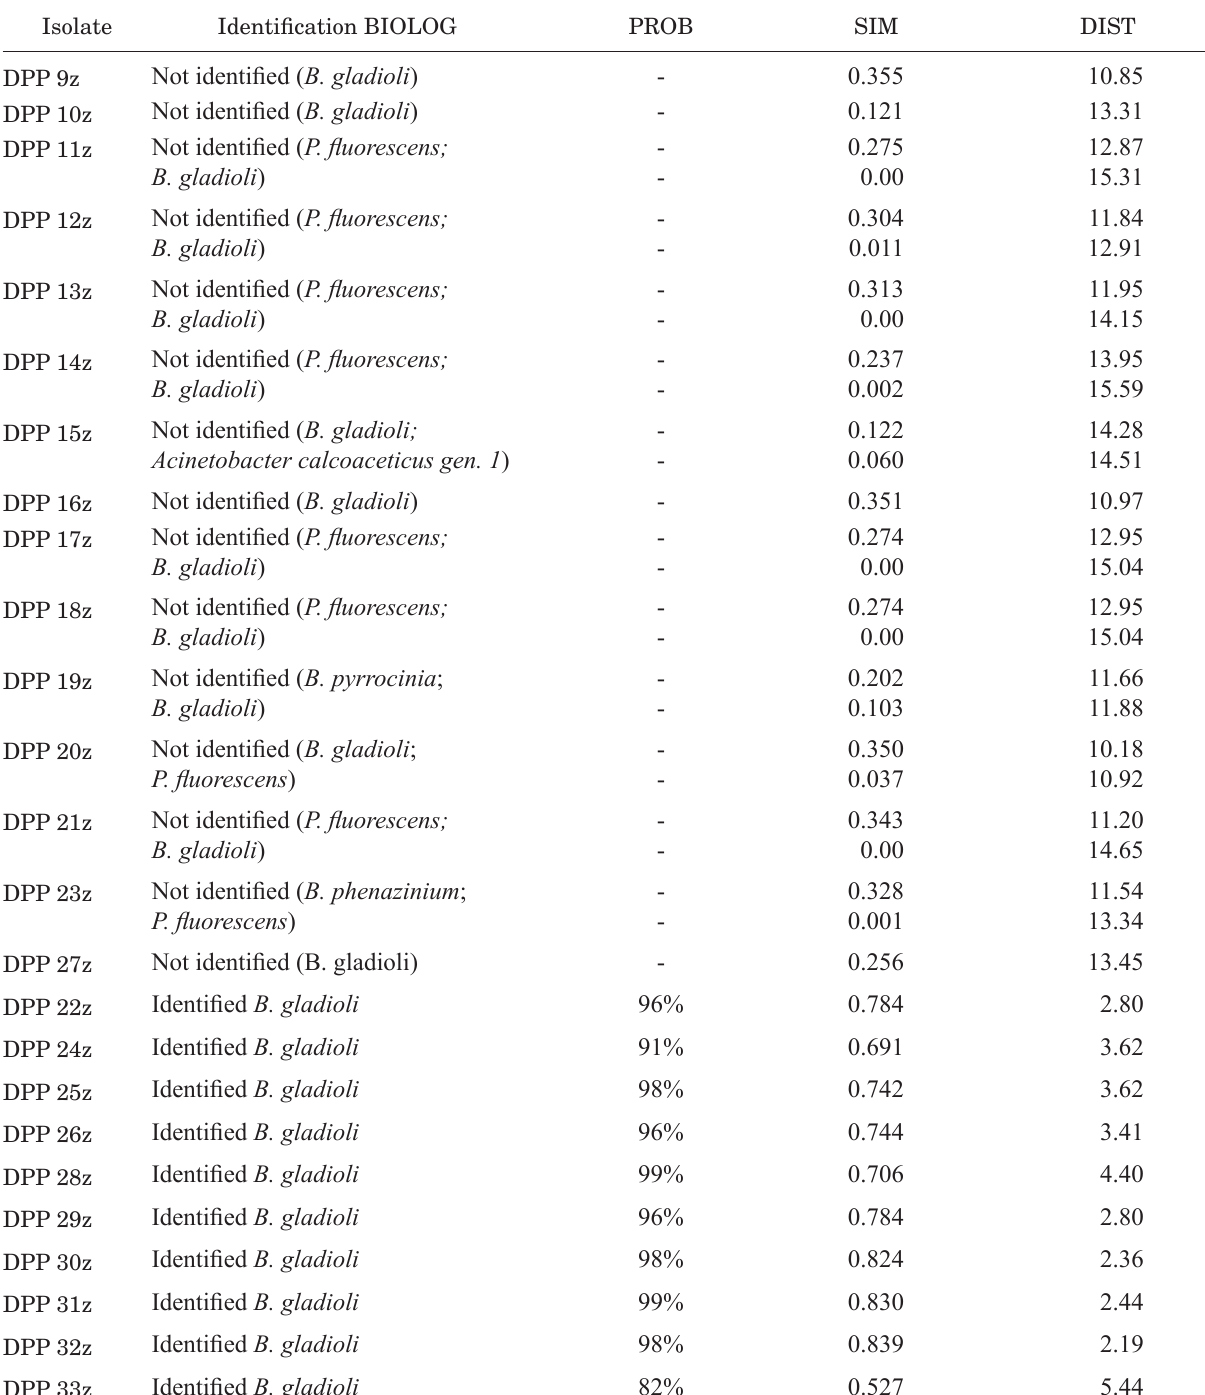
Table 2. Results of Biolog test for 25 saffron